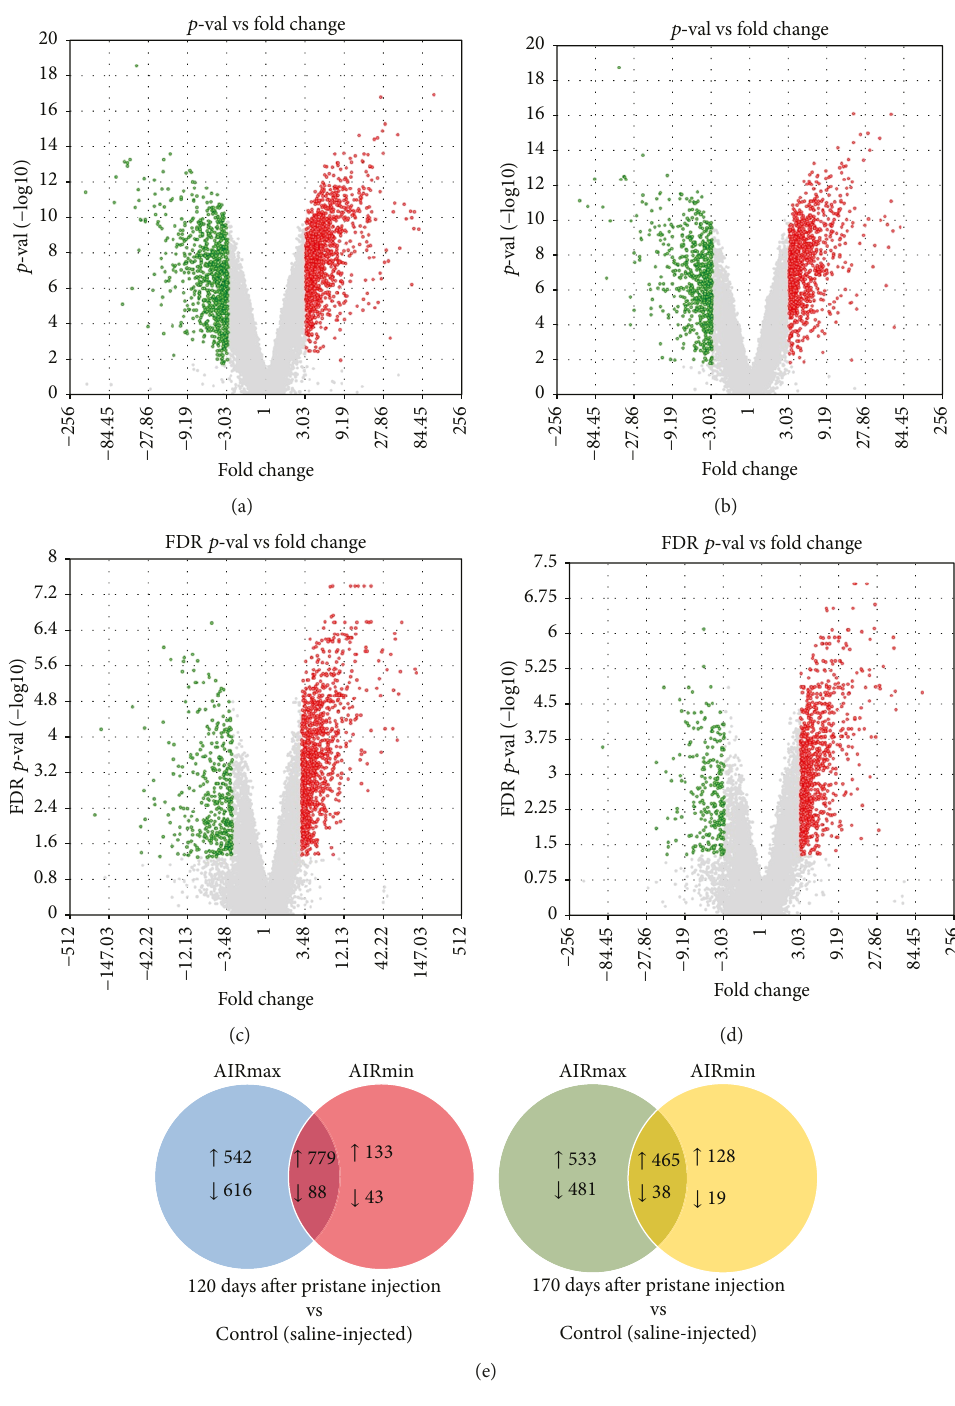
Figure 1: Gene expression modulation in AIRmax and AIRmin mice after pristane injection. (a – d) Upregulated (red) and downregulated (green) genes 120 and 170 days after pristane injection in peritoneum. (a) AIRmax 120 days, (b) AIRmax 170 days, (c) AIRmin 120 days, (d) AIRmin 170 days, and (e) exclusive and common DEGs in AIRmax and AIRmin lines injected with pristane and compared to controls. Di ff erentially expressed genes (DEGs) were detected using unpaired one-way ANOVA in the Transcriptome Analysis Console 3.0 (TAC) software, with FDR < 0 05 considering a minimum di ff erence of 3 times for di ff erentially expressed genes. N = 5 animals per